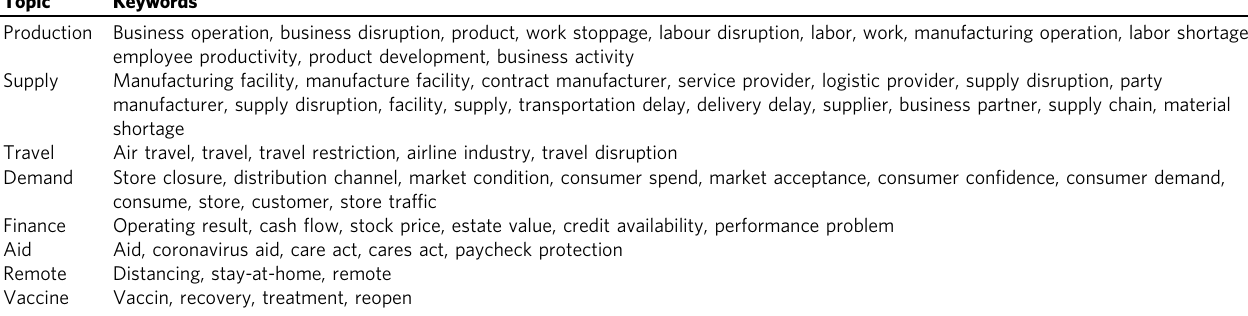
Production Business operation, business disruption, product, work stoppage, labour disruption, labor, work, manufacturing operation, labor shortage, employee productivity, product development, business